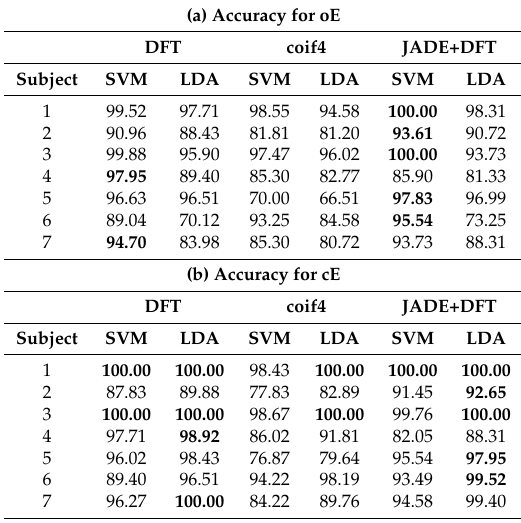
Table 1. Comparison of the classification accuracies (%). Bold values indicate the best result for each